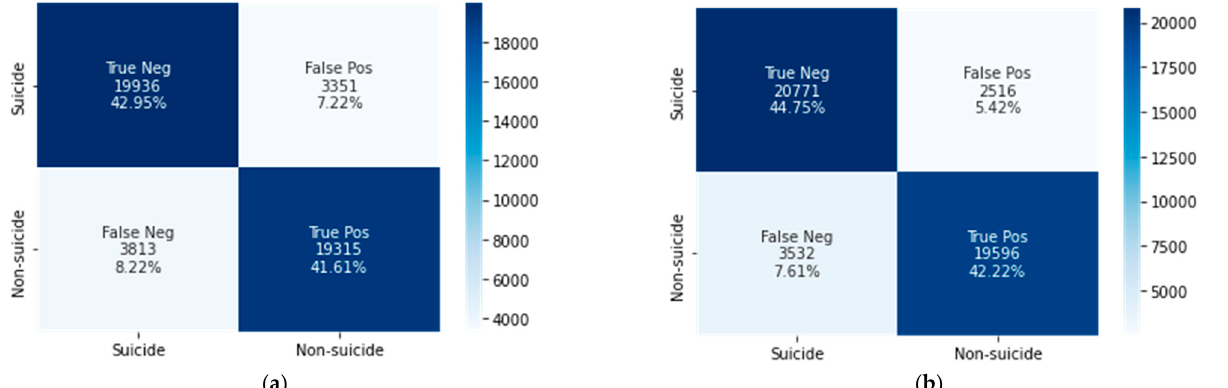
Table 4. Test results using LIWC-based